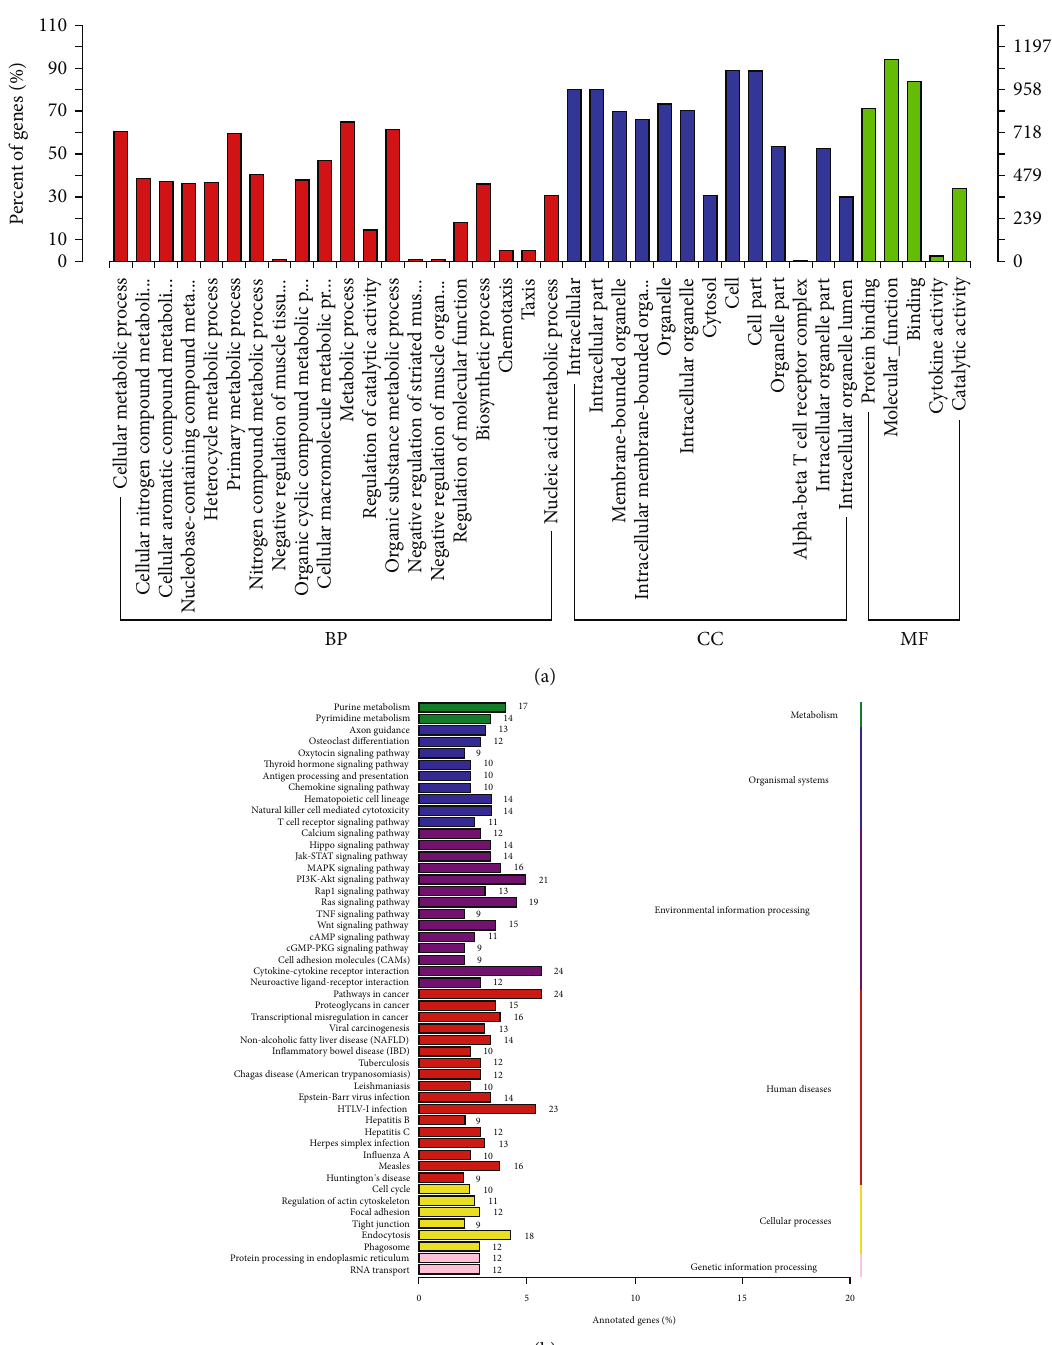
Figure 3: The potential biological functions of DE-lncRNA target genes. (a) Gene Ontology (GO) functional enrichment of DE-lncRNA target genes. (b) KEGG pathway enrichment of DE-lncRNA target